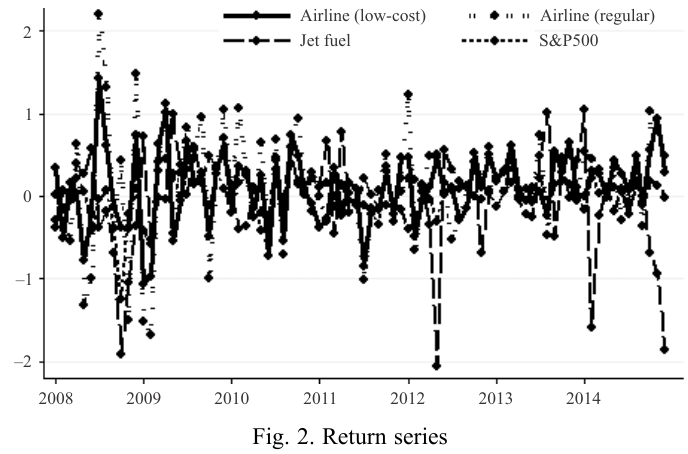
Fig. 2. Return series